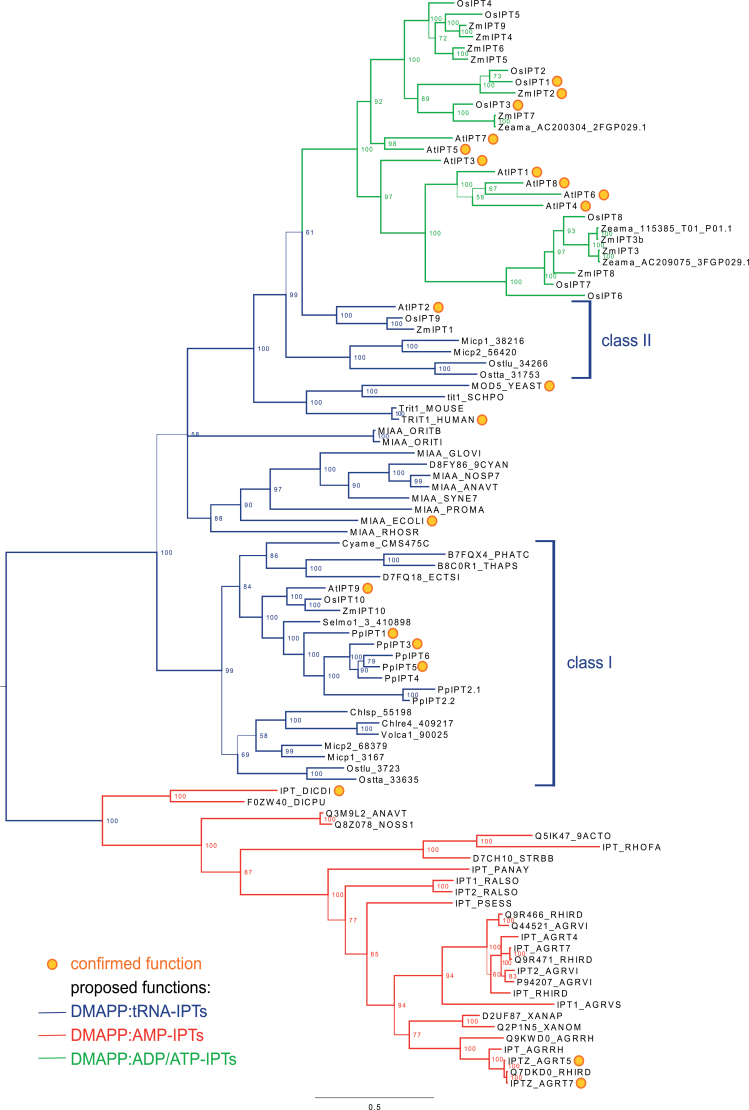
IPT phylogeny. Branch lengths and support in the form of posterior probabilities (presented at internal nodes and branch thickness) were inferred using MrBayes (Ronquist and Huelsenbeck, 2003) based on a manually curated T-Coffee (Notredame et al., 2000) protein alignment comprising 97 representative members of the IPT family. Confirmed IPT functions are designated with yellow dots: DMAPP:tRNA-IPT references, MiaA_Ecoli (Caillet and Droogmans, 1988), TRIT1_HUMAN (Golovko et al., 2000), MOD5_YEAST (Dihanich et al., 1987), AtIPT2 (Golovko et al., 2002), AtIPT9 (Miyawaki et al., 2006), PpIPT1 (Yevdakova and von Schwartzenberg, 2007), PpIPT3,5 (Patil and Nicander, 2013); DMAPP:AMP-IPT references, IPT_DCDI (Taya et al., 1978), IPTZ_AGRT7 (Akiyoshi et al., 1985), IPTZ_AGTT5 (Beaty et al., 1986); DMAPP:ADT/ATP-IPT references, AtIPT1,4 (Kakimoto, 2001), AtIPT3,5,6,7,8 (Miyawaki et al., 2006; Sakakibara, 2006), OsIPT1,3 (Sakamoto et al., 2006), ZmIPT2 (Brugiere et al., 2008). Proposed (homology-based) functionality for the clades is given by the colouring of the branches. Gene identifier and species names are available in Supplementary Table S1 at JXB online.